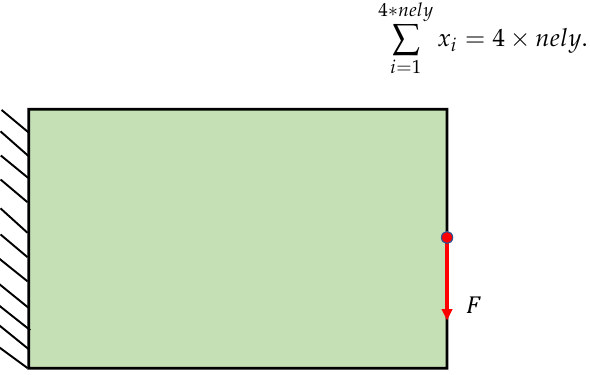
Figure 6. Design domain of the cantilever beam.